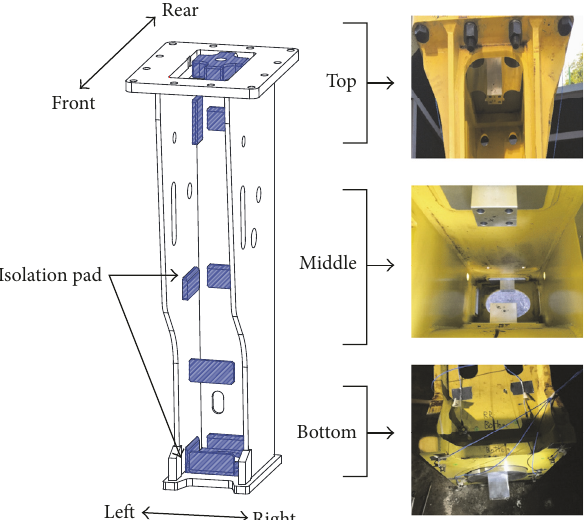
Figure 10: Position of the isolation pad in the hydraulic breaker and triaxial excitation jig for FRF